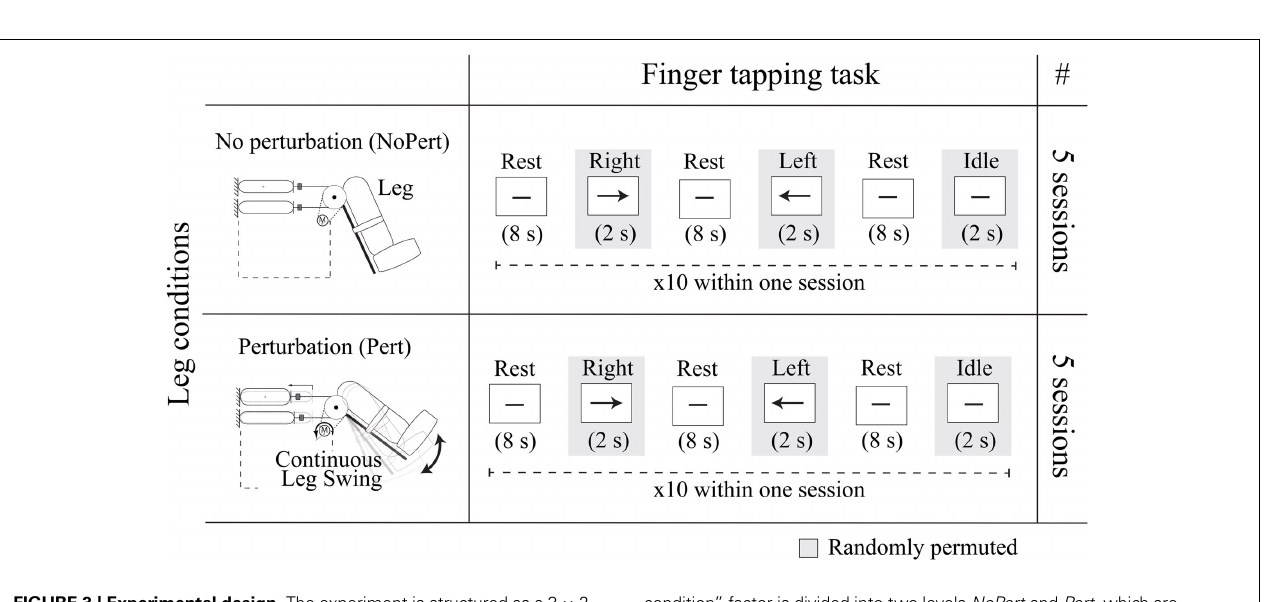
condition” factor is divided into two levels NoPert and Pert , which are represented,respectively,inthefirstandsecondrowsofthetable.Tonotethat Rest is the resting period between tasks and that the visual cues of the tasks are randomly permuted within a session. Moreover, in the last column, the number of sessions performed for each experimental condition are